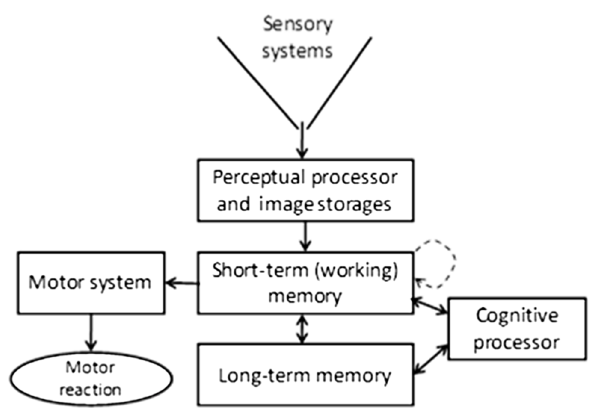
Figure 1. Outline of the Human Processor model.